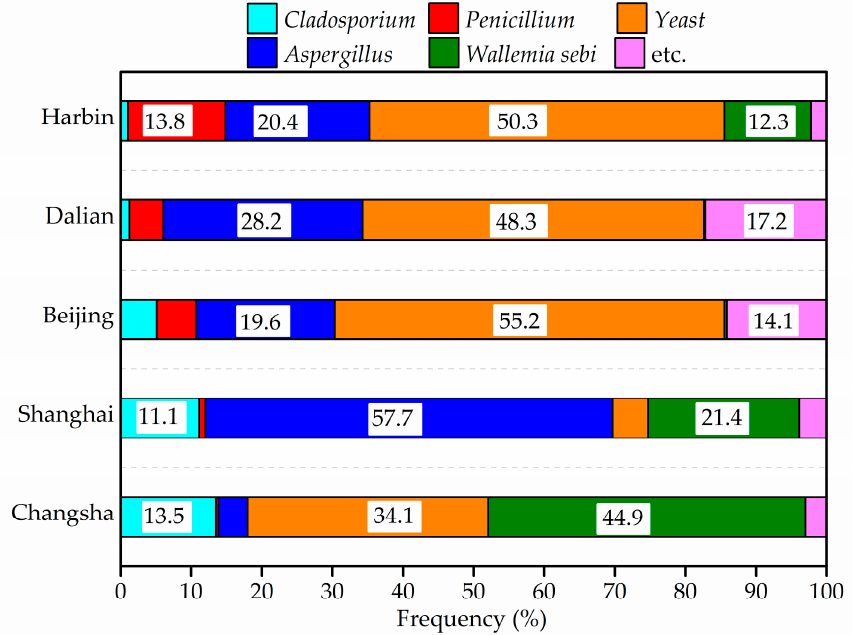
Figure 9. Frequency of settled fungi species in house dust in winter.